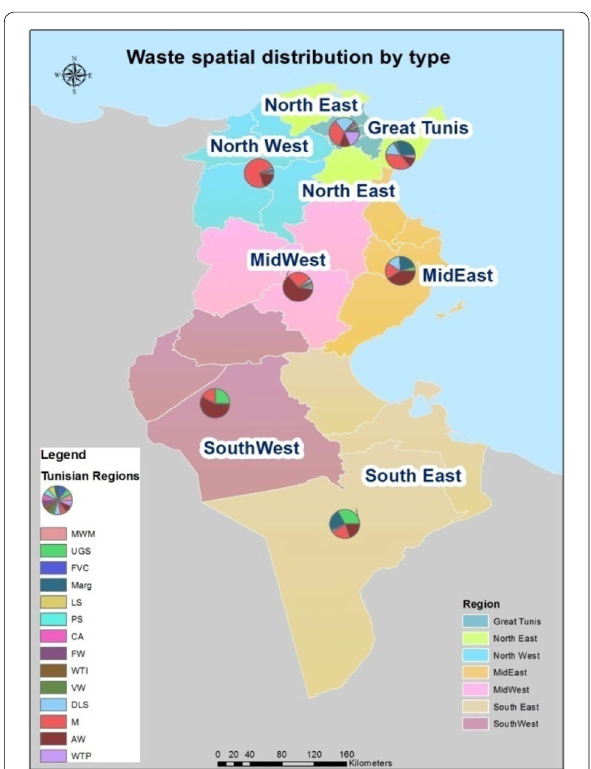
Fig. 18 Topology of valorizable organic waste in